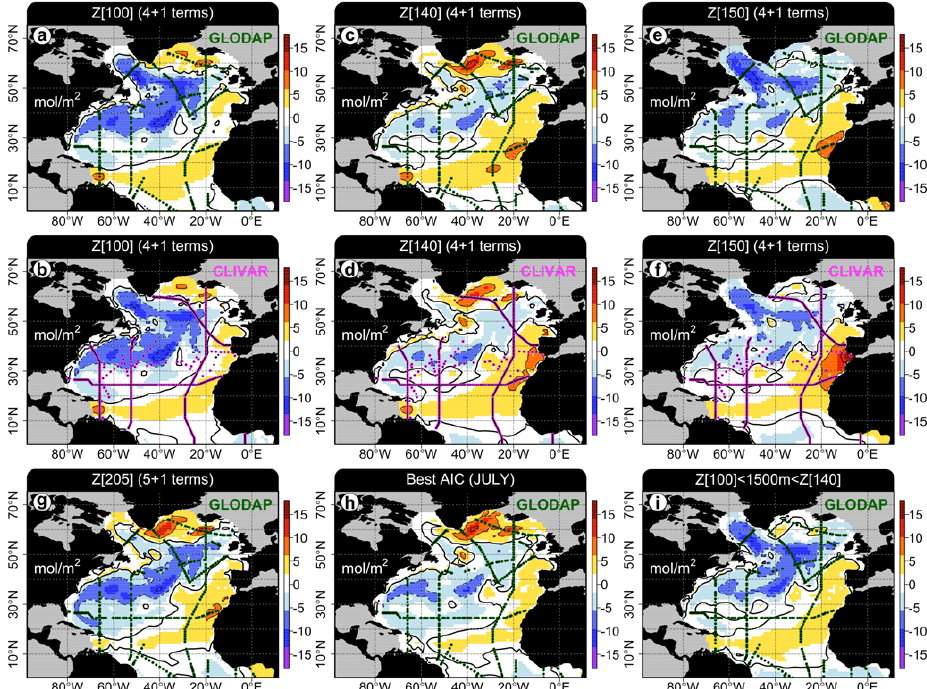
Fig. 11. Absolute errors in anthropogenic carbon column inventory changes between July 2005 and 1995 mapped from either the GLODAP (green) or CLIVAR (magenta) stations calculated from sampling networks that change in time ( 1C hybrid (positive) contours are drawn in increment of 6molm − 2 . The thick lines marks the 0 contour. Results shown for models (a, b) Z 100 , (c, d) Z 140 , (e, f) Z 150 , (g) Z 205 , (h) for the “best AIC” models selected by minimum AIC for each layer and each time point (strategy 1) and (i) the merged product using Z 140 below 1500m and Z 100